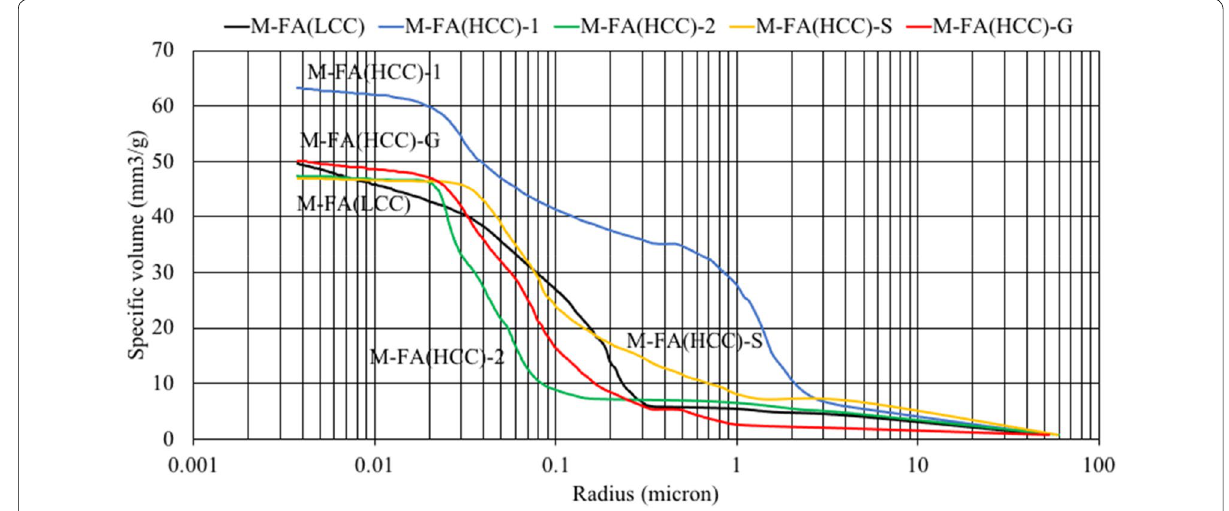
Fig. 4 Pore size distribution of the investigated mortars.